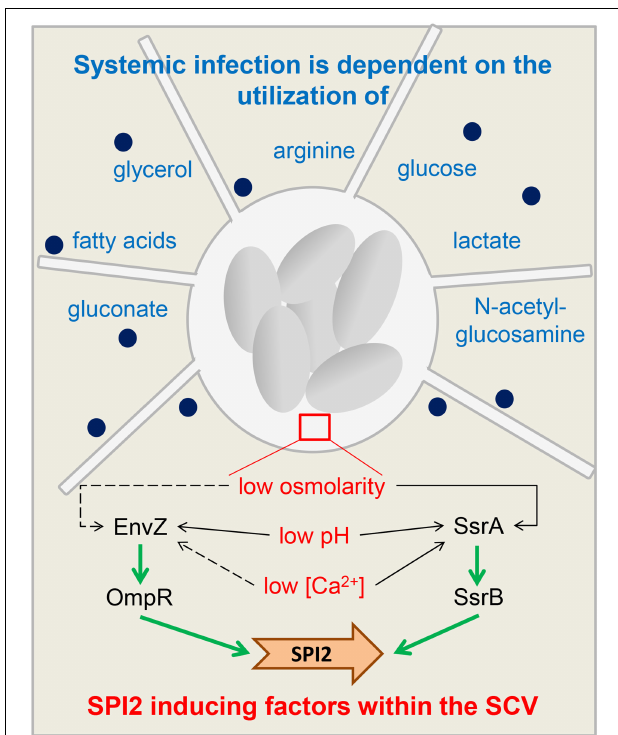
FIGURE 2 | Regulatory adaptations and nutritional requirements of Salmonella. A schematic overview of functions of SPI2 during host cell infection and nutritional requirements to manifest a systemic infection. The Salmonella -containing vacuole (SCV) with replicating Salmonella (gray ovals) is connected to Salmonella -induced filaments. Blue writing: substrates Salmonella depends on to manifest systemic infections (Steeb et al., 2013). Dark blue spots: SPI2 effectors. The insert (brown rectangle) shows key factors influencing SPI2 expression (Haraga et al., 2008). Detection of low osmolarity, low calcium concentrations and acidic pH by the two-component systems Envz/OmpR and SsrAB inside the SCV leads to activation of SPI2 gene expression (Garmendia et al., 2003). Dotted arrow: minor effect on EnvZ/OmpR activity and SsrAB activity. Non-dotted arrow: strong effect on EnvZ/OmpR activity and SsrAB